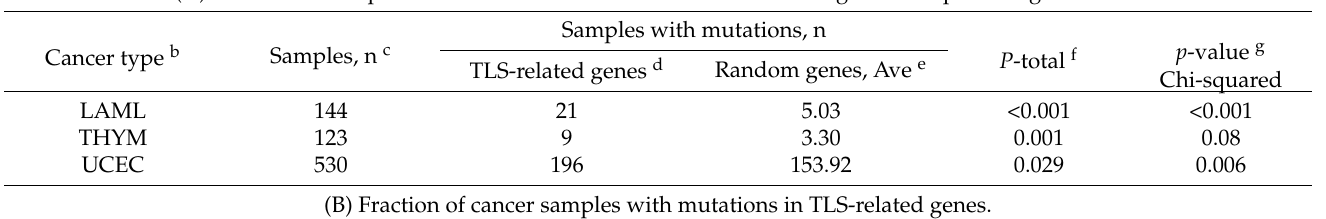
(B) Fraction of cancer samples with mutations in TLS-related